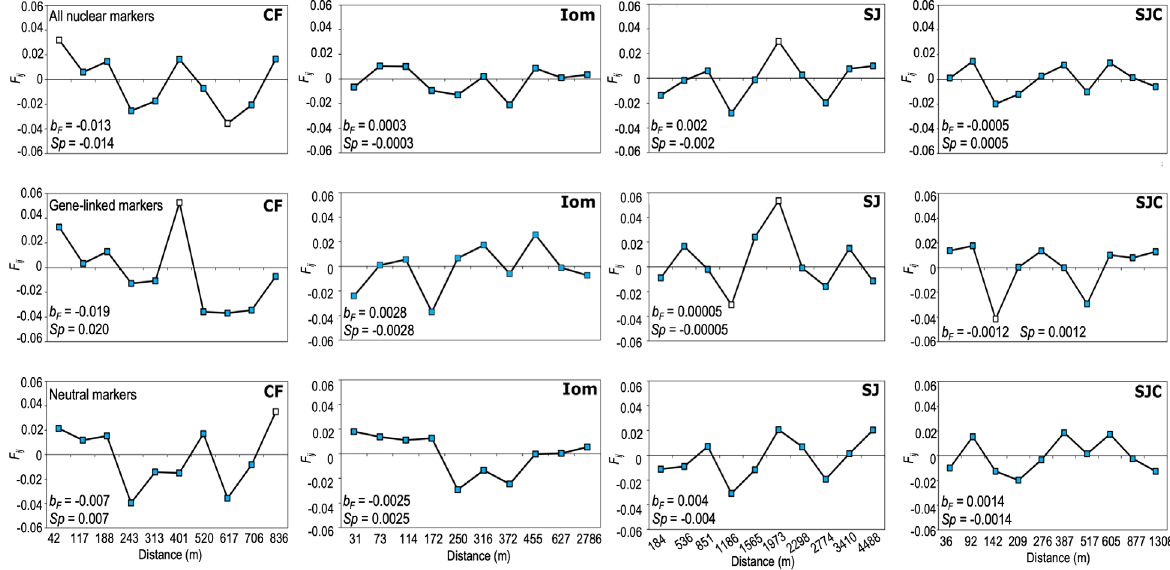
Figure 2. Correlograms of kinship coefficient measures ( F fragments of C. xanthocarpa . Not filled squares are significant at the 5 %